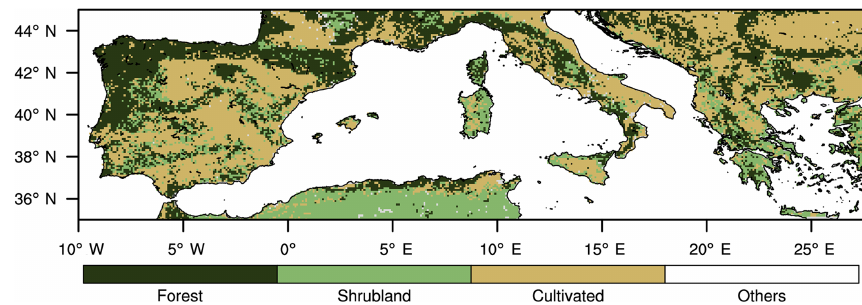
Figure 1. Geographical distribution of the types of vegetation cover/land use as derived from the GLC2000 database.